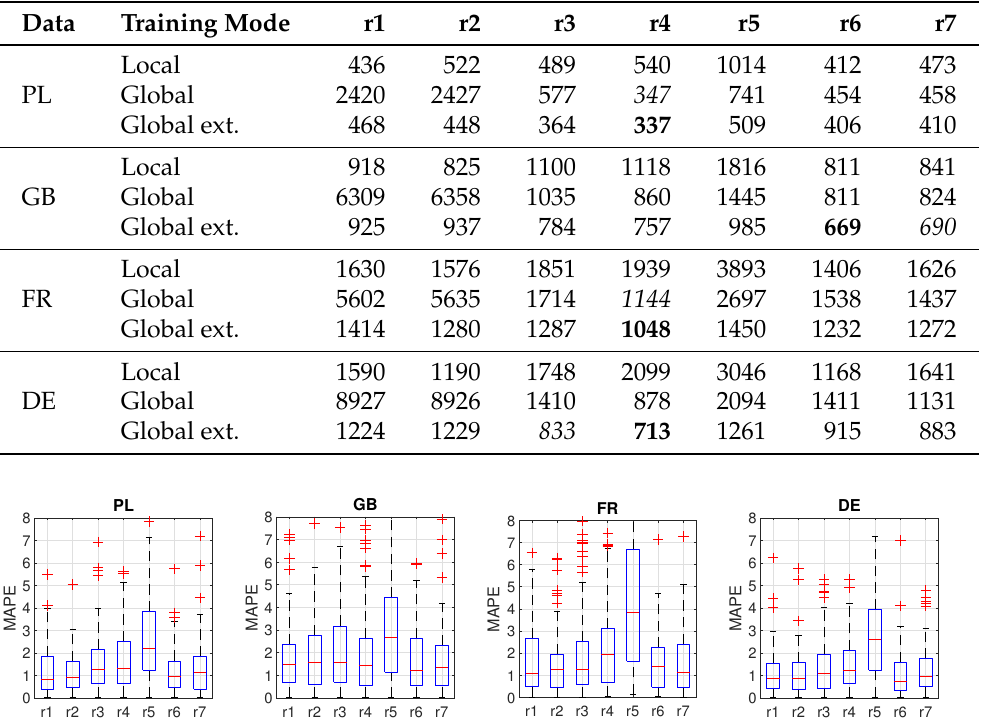
Table 2. Validation RMSE for different input patterns r1–r7 and training modes (lowest errors in bold, second lowest errors in italics).